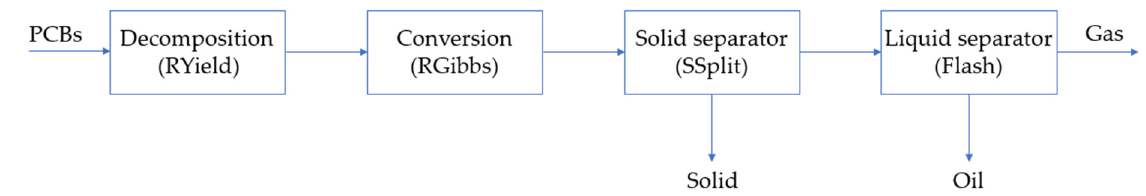
Figure 1. Block diagram of the developed pyrolysis Figure 1 . Block diagram of the developed pyrolysis model.